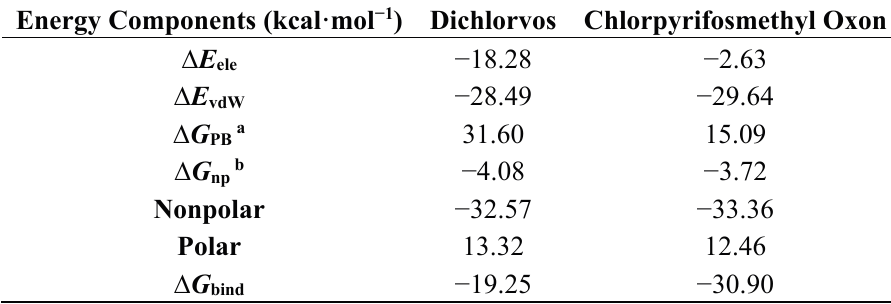
Figure 10. The relative Free energy surfaces along the first two principle components (PC-1, PC-2) of ( a ) chlorpyrifosmethyl oxon-APH; and ( b ) dichlorvos-APH during 100 ns generated by Sigma plot 12.0 (12.0, Systat software company, San Jose, CA, USA). Table 3. The MM-PBSA score for the two complexes (kcal·mol − 1